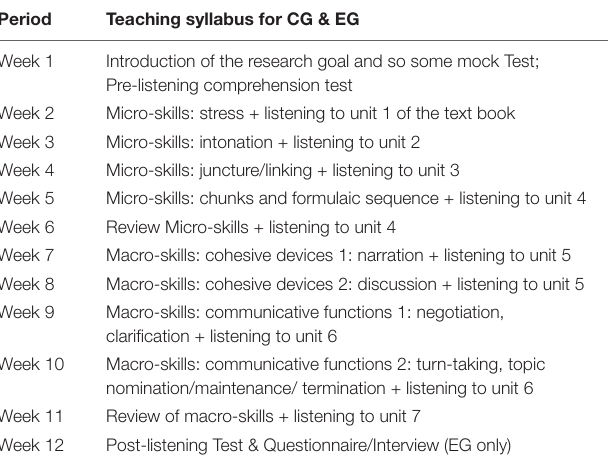
TABLE 5 | The overall teaching syllabus for both